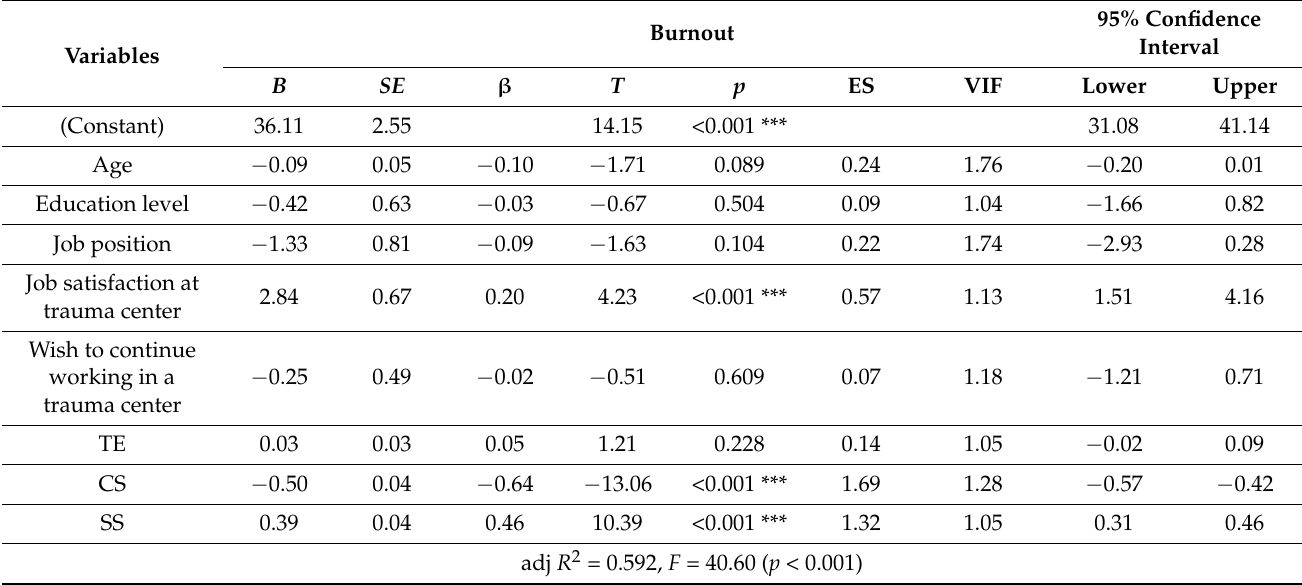
Table 6. Predictors of burnout (N =